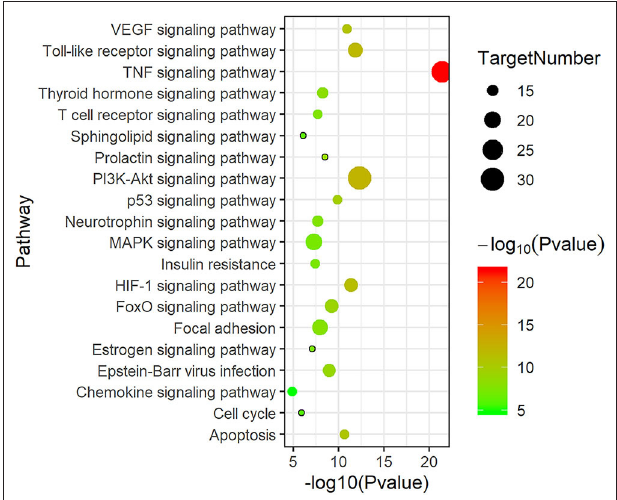
FIGURE 4 | The top 20 Kyoto Encyclopedia of Genes and Genomes (KEGG) pathway enrichment analyses of 137 target proteins ( P < 0.05).